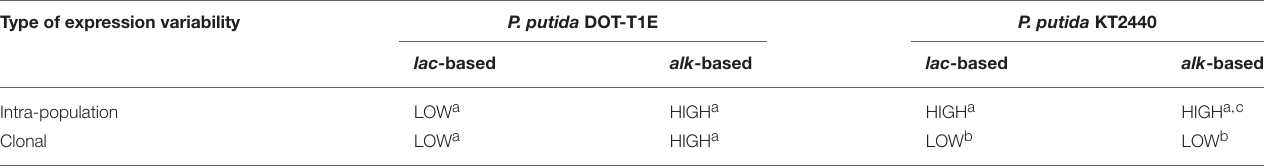
TABLE 3 | Expression variabilities observed for P. putida DOT-T1E and P. putida KT2440. Type of expression